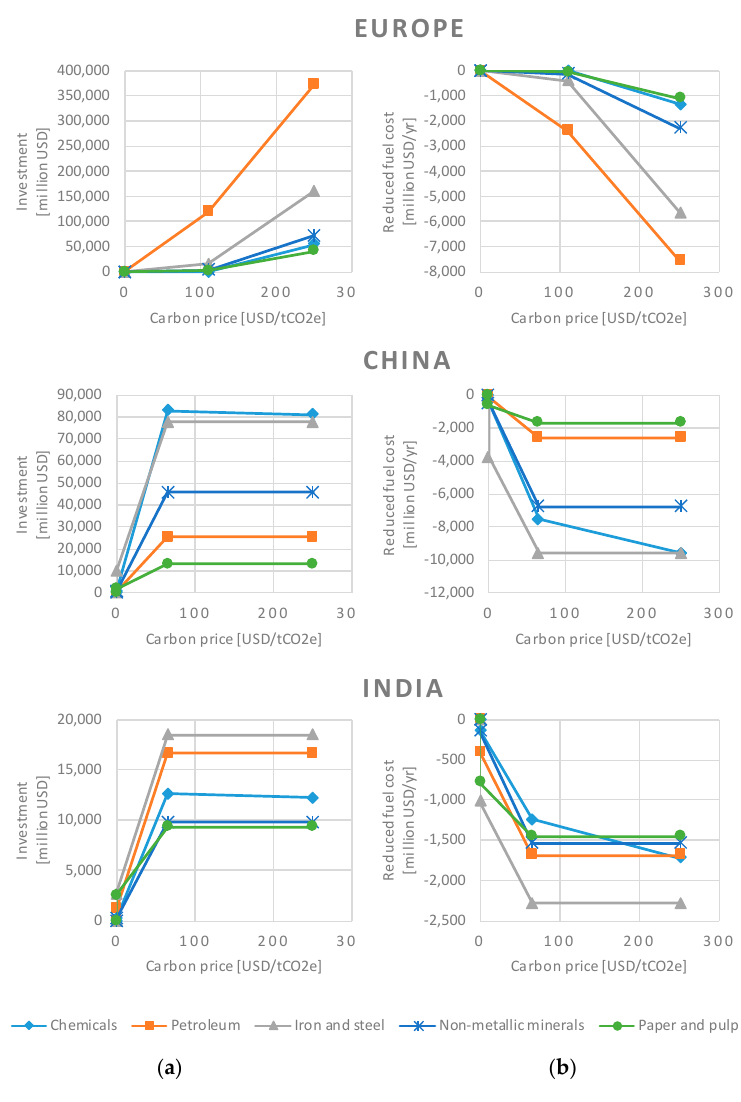
Figure 4. Total investment requirements in million USD ( a ) and reduced fuel costs in million USD per year ( b ) resulting from energy efficiency measures in different industrial sectors in 2030 as a function of an exogenous carbon price (USD/tCO 2 e).